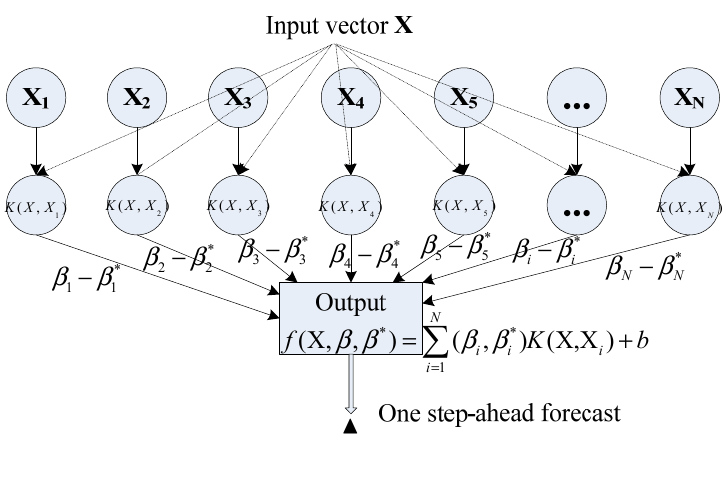
Figure 2. The forecasting process of a SVR